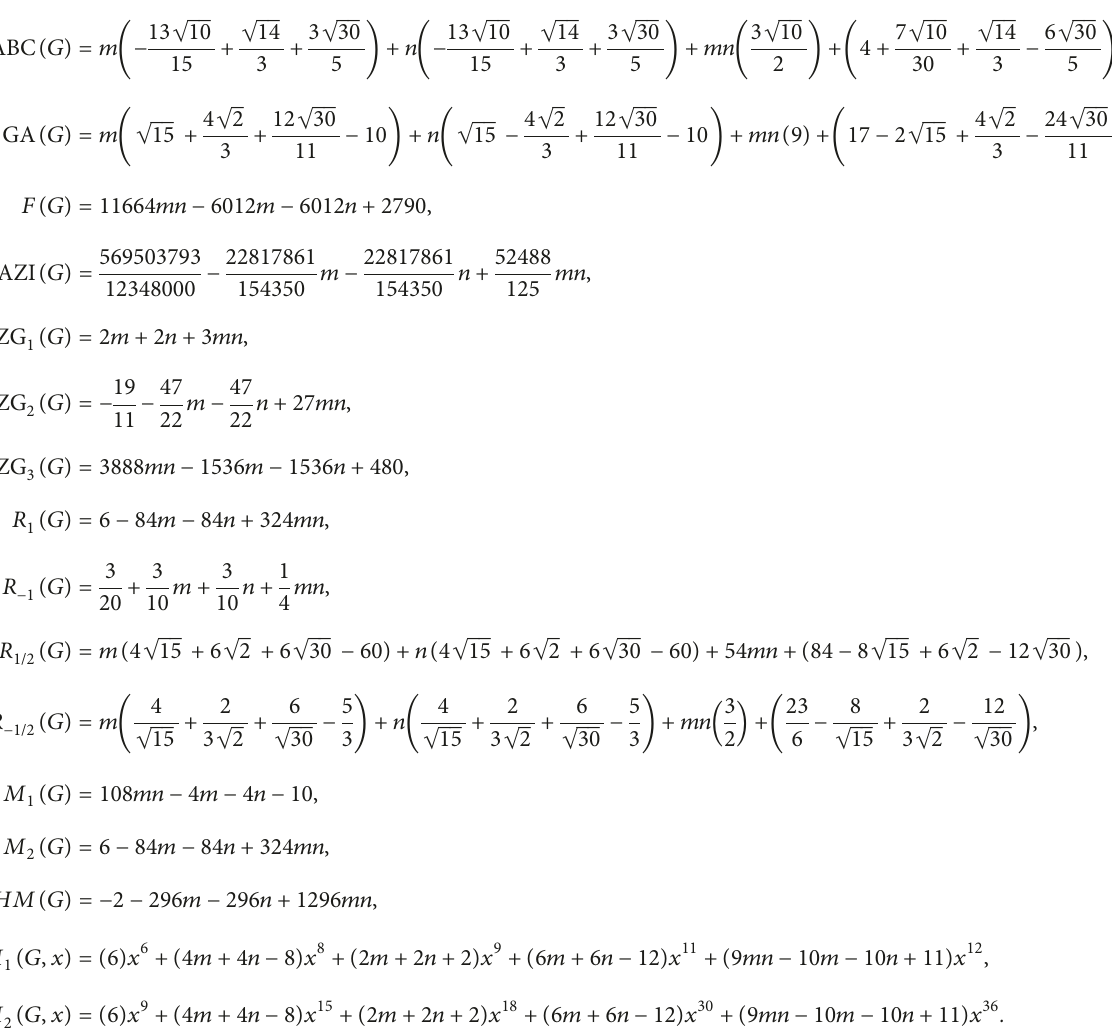
Figure 1: Structure of antimony telluride ( Sb being connected each with two unit cells. Antimony atoms are red, and telluride atoms are black